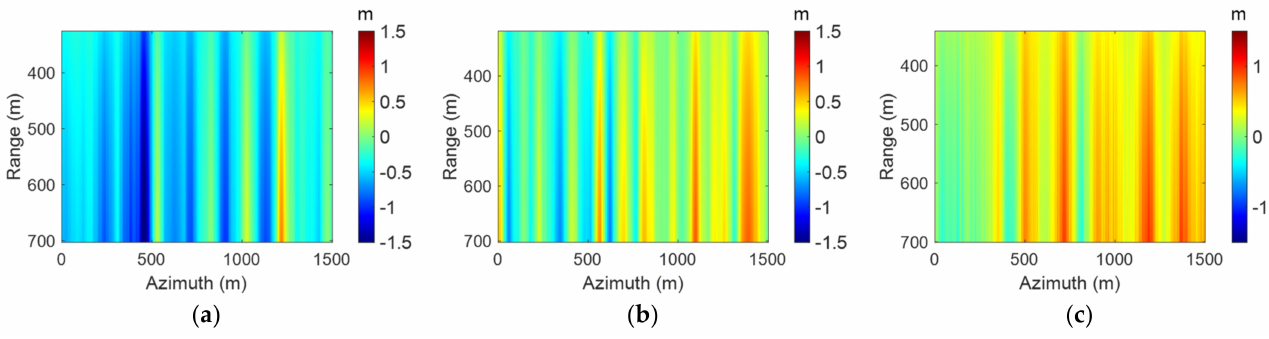
Figure 8. Coupling attitude altimetric errors without correction of the shift of imaging position. ( a ) RZ14. ( b ) RZ16. ( c )